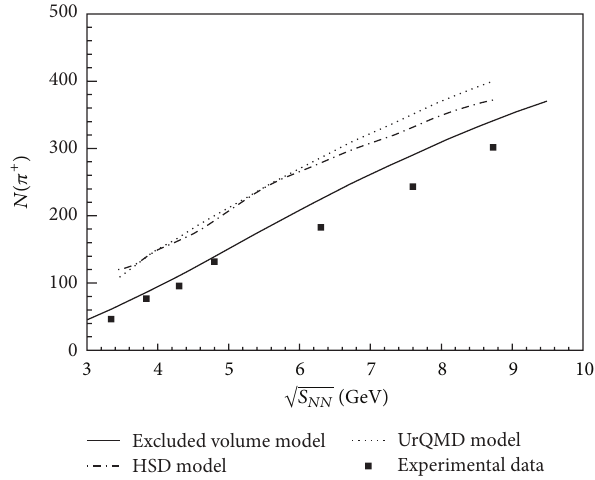
Figure 2: Variation of total multiplicity of produced 𝜋 + with respect to √ 𝑠 𝑁𝑁 . Dash-dotted and dotted curves are the results obtained from HSD and UrQMD models, respectively [29]. Experimental data is taken from [30–35].